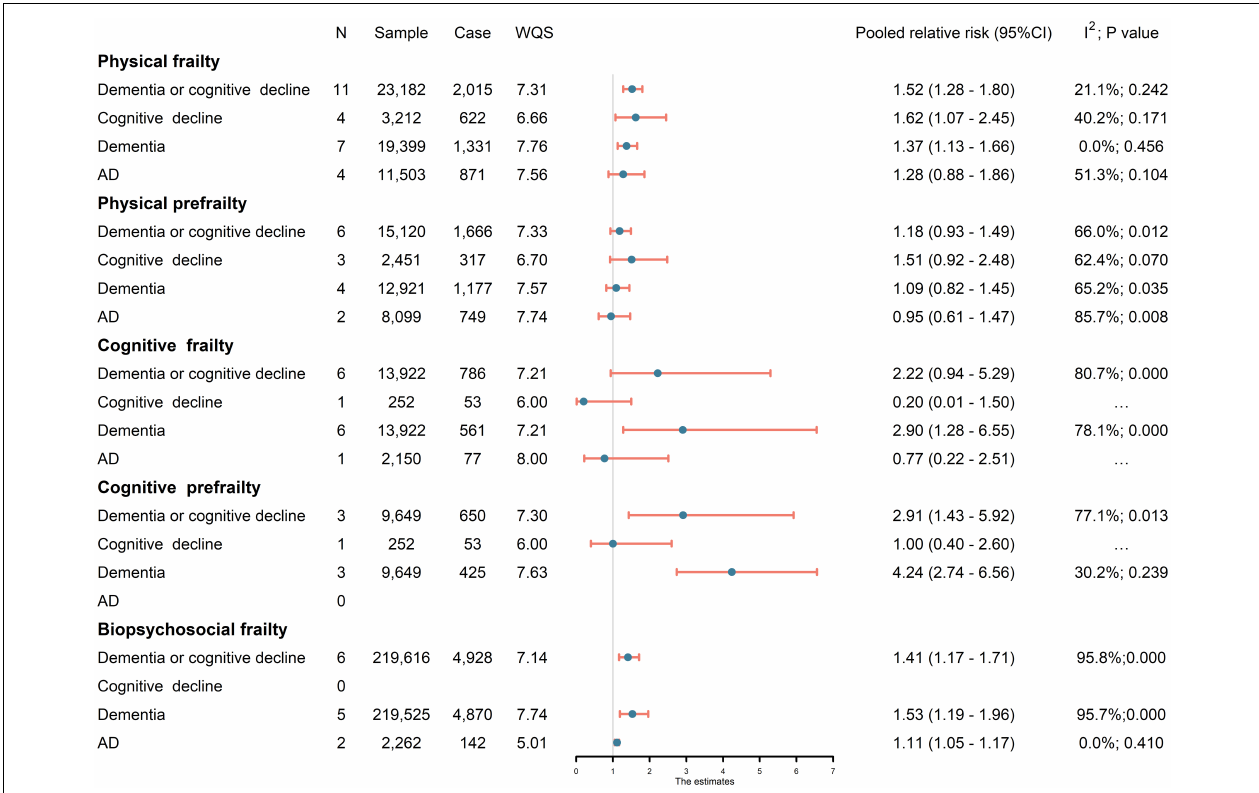
FIGURE 2 | Association of frailty with risk of cognitive disorders. Since physical frailty involved both prefrailty (a condition between frail and non-frail) and frailty (Morley et al., 2013), cognitive frailty involved both cognitive prefrailty and cognitive frailty. AD, Alzheimer’s disease; CI, confidence interval; N, number of studies; WQS, weighted quality